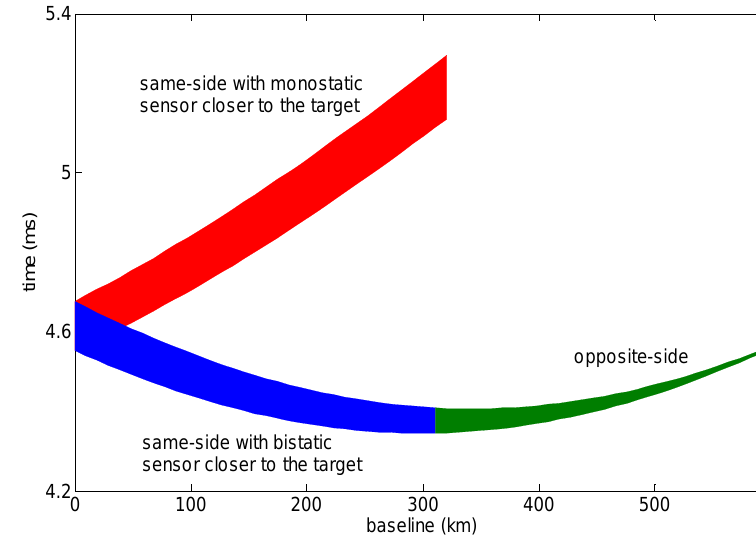
Figure 3. Bistatic time interval required to receive the same monostatic swath width (40 km) for different observation strategies as a function of the baseline (platforms operating at 620 km altitude in parallel